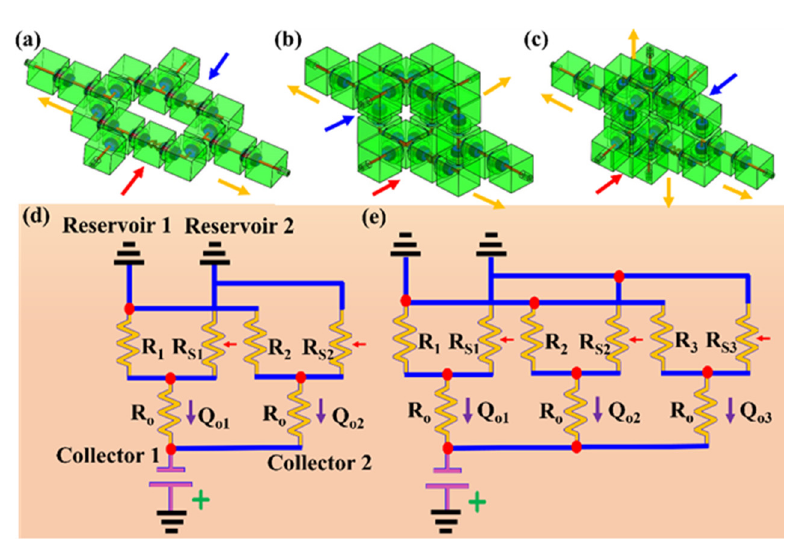
Figure 4. The tunable mixer with ( a ) two, ( b ) three, and ( c ) four outlets. ( d , e ) comparison of equivalent circuit models for two- and three-outlet parallelized configurations of the tunable mixer system.